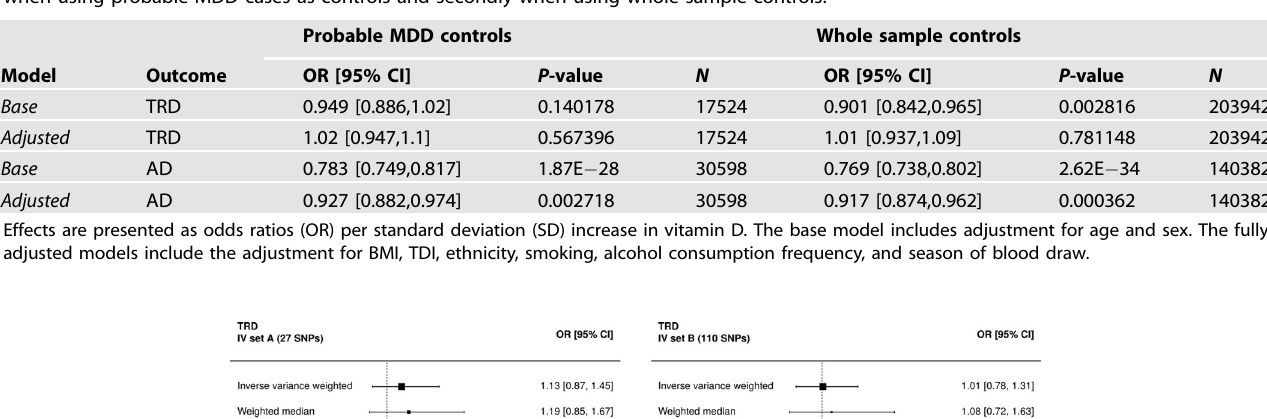
Table 2. Observational associations of serum vitamin D with depression subtypes (TRD — treatment-resistant depression; AD — atypical depression) when using probable MDD cases as controls and secondly when using whole sample controls.